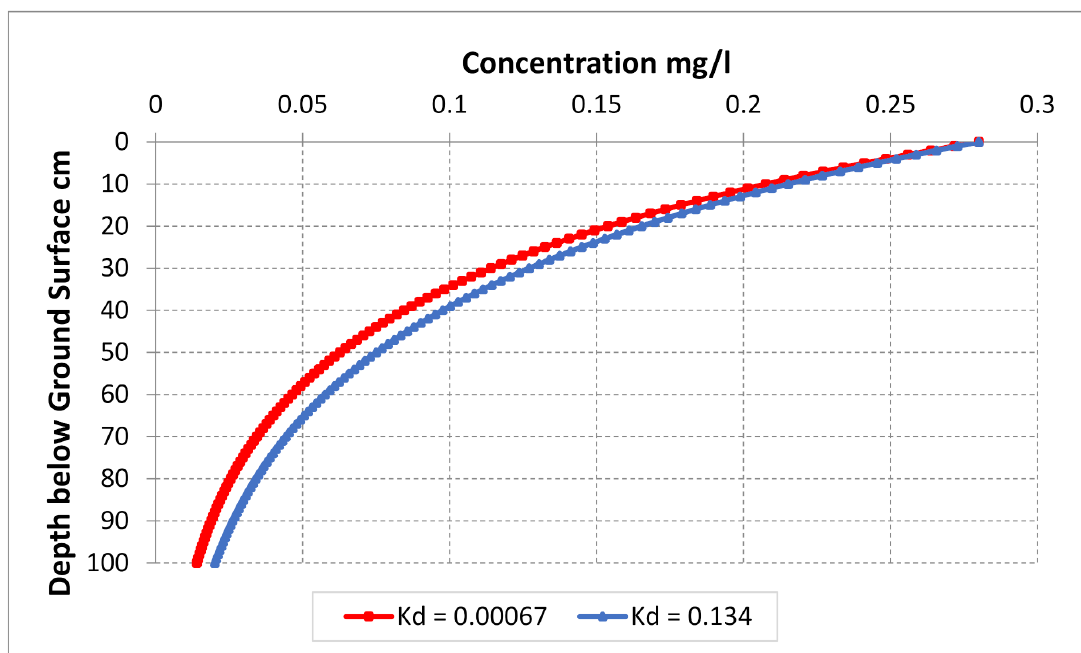
Figure 5. The effect of the distribution coefficient ( K d )—Loam soil.